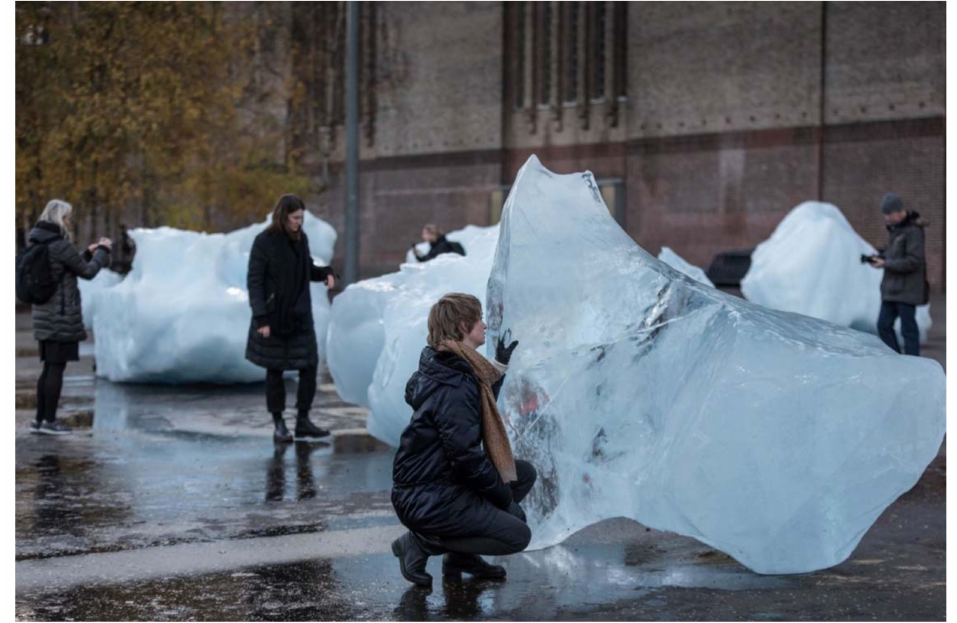
Figure 3. Ice Watch by Olafur Eliasson and Minik Rosing. Supported by Bloomberg. Installation: Bankside, outside Tate Modern, 2018. © 2018 Olafur Eliasson. Used by